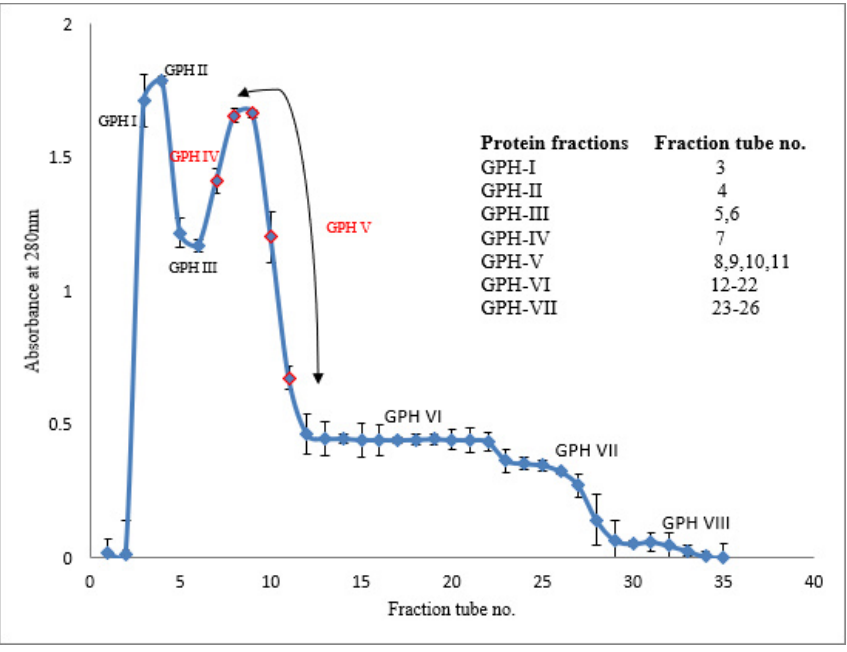
Figure 4. Gel permeation chromatography (GPC) of 30 min pepsin hydrolysates on a Sephadex G-25 column. Values and error bars indicate the means and standard deviations, respectively, of triplicate analyses for each protein fraction. Values highlighted in red indicate the highest bioactive protein fractions (GPH-IV and GPH-V).